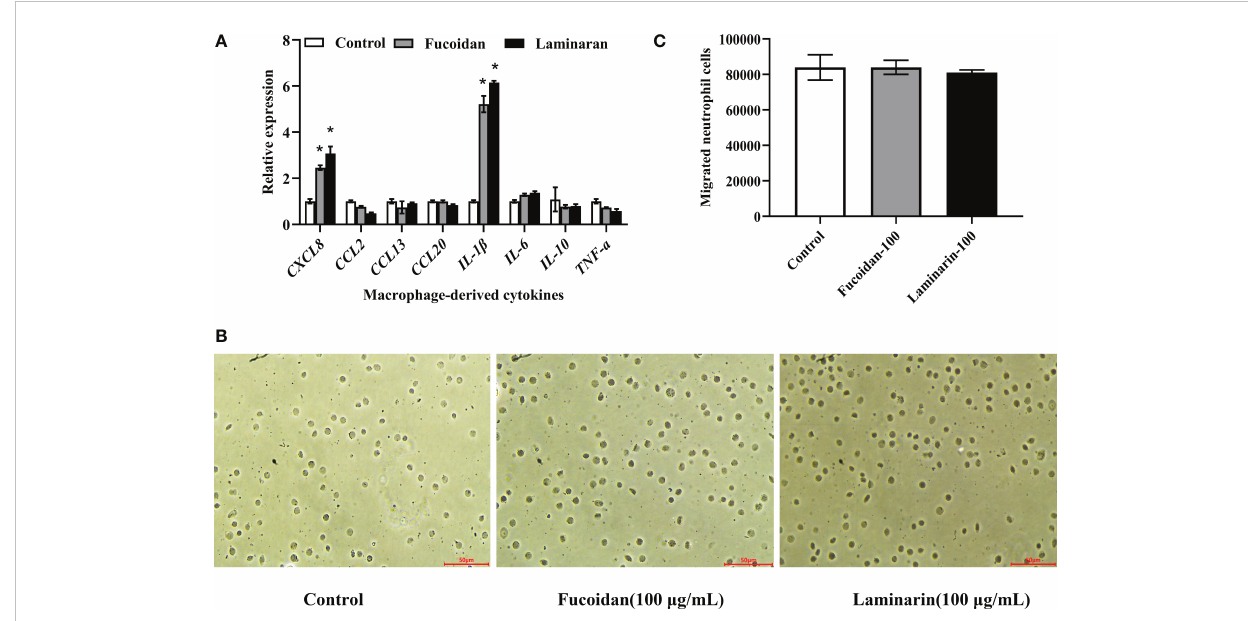
FIGURE 6 Effects of fucoidan and laminarin on the cytokines expression in macrophages and the chemotaxis of neutrophils. (A) Regulation of fucoidan and laminarin on the expression of cytokines in macrophages, and the asterisk indicated signi fi cant difference ( P < 0.05). (B) Effects of fucoidan and laminarin cultured macrophages supernatant on the chemotaxis of neutrophils. Scale bars =50 m m. (C) Count statistics of chemotactic